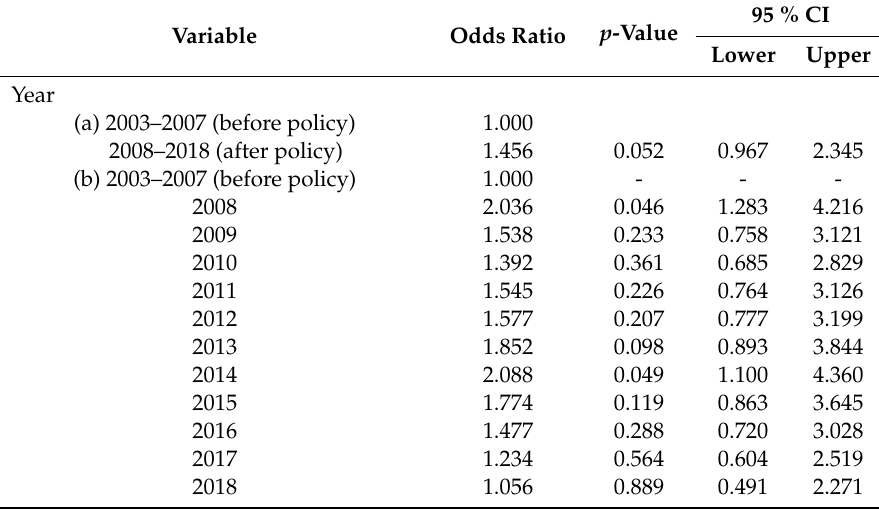
Table 4. Univariate logistic regression of immune status after hospital policy ( n =